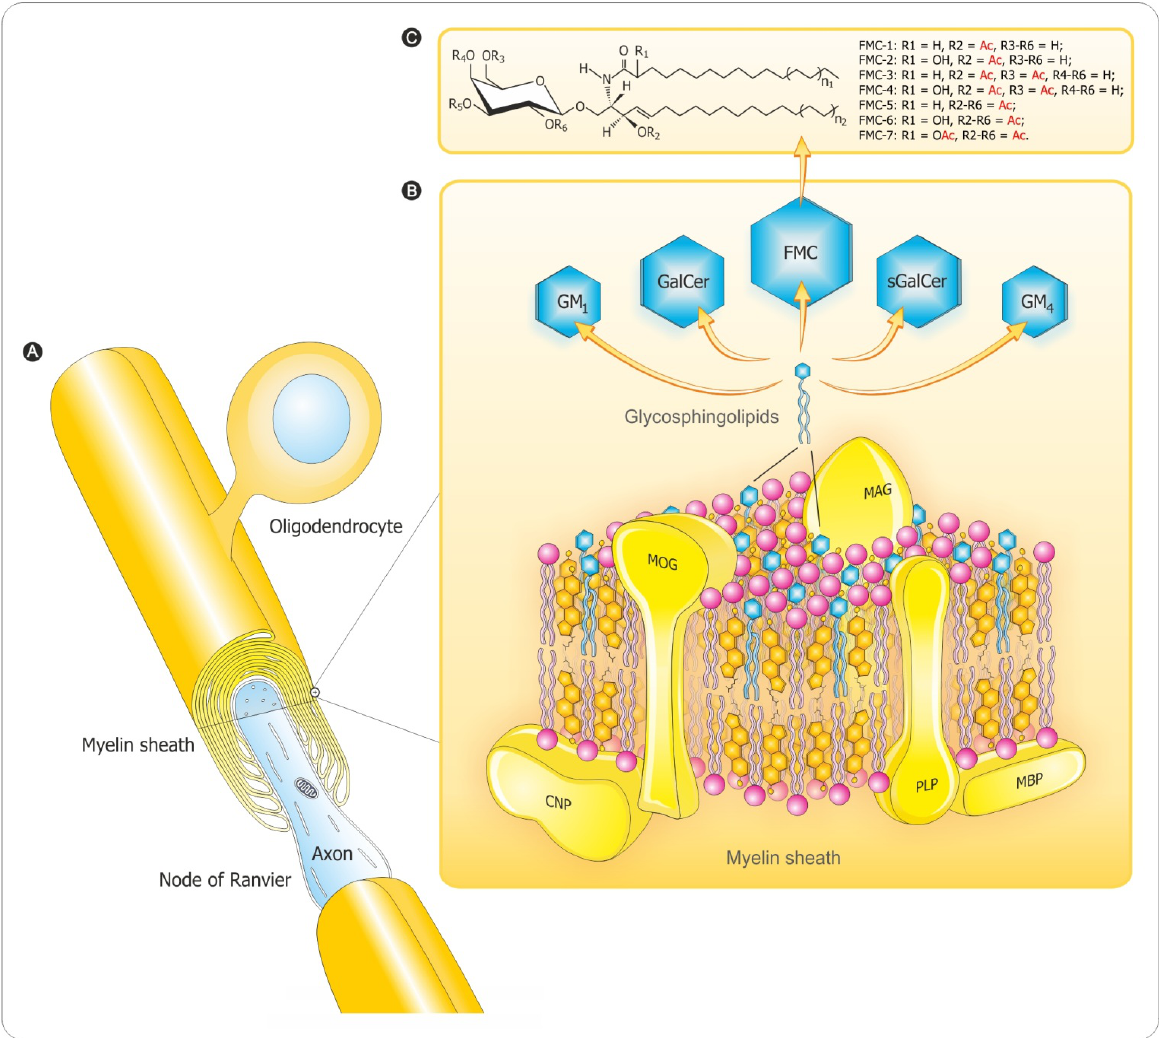
( B ) 3D-molecular composition and conformation-based assembly and ( C ) the unique sphingosine 3- O -acetylated-GalCer GL series. The diagram depicts arrangement of complex lipids (cholesterol, PLs and GLs) and most abundant proteins (PLP, MBP). The relative molar constancy of lipids: cholesterol (C):PLs:galactosylceramide (GalCer) is C:PLs:GalCer = 2:2:1. Proteins are marked in yellow and the comprising lipids are as follows: cholesterol in orange, PLs in pink and the glycosphingolipids (FMC, fast migrating cerebrosides;